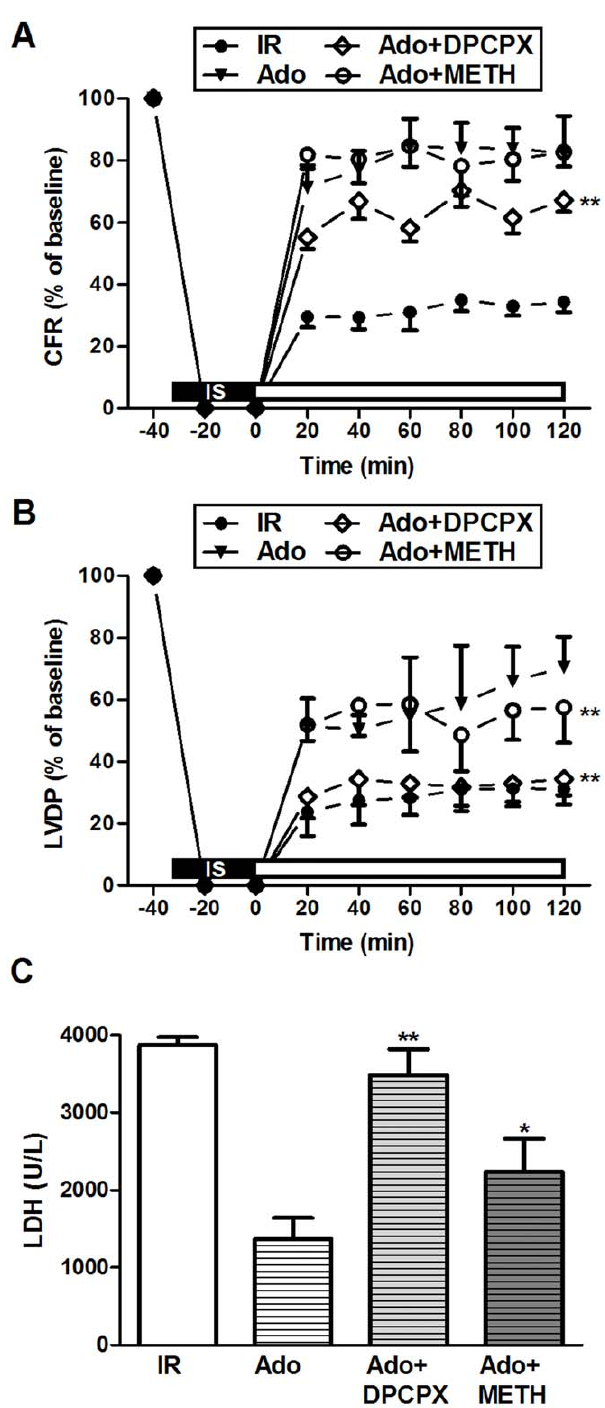
Figure 4. Effects of A 1 AR and M 2 AChR blockade on adenosine- mediated cardioprotection. (A) DPCPX abolished the increase in coronary flow rate (CFR) mediated by adenosine; METH had little effect on CRF. (B) DPCPX abolished the left-ventricular developed pressure (LVDP) improvement mediated by adenosine; METH dampened the effect on LVDP (C) DPCPX and METH suppressed the decrease in LDH release mediated by adenosine in coronary effluent. IR: ischemic reperfusion; Ado: adenosine; IS: iscehmia. * P , 0.05, ** P , 0.01 vs. IR; # P , 0.05, # # P , 0.01 vs. Ado (n=6 in each group).